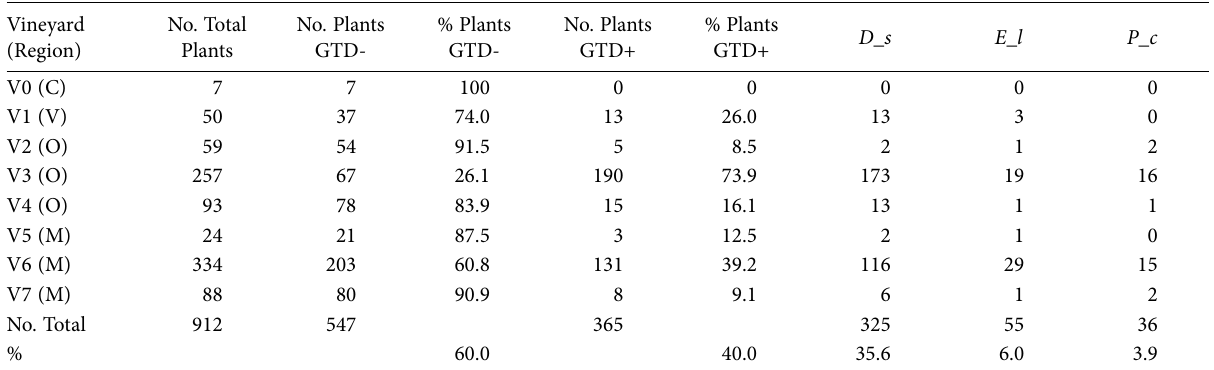
Table 3. Incidence of GTDs and GTD pathogens in seven Chilean vineyards. The vineyards are ordered from north to south of Chile. V = Vineyard, C = Coquimbo, V = Valparaíso, O = O´Higgins and M = Maule, n = number, GTD- = plants with no GTD fungi, GTD+ = plants with presence of GTD fungi. D_s = Diplodia seriata , E_l = Eutypa lata and P_c = Phaeomoniella chlamydospora . The numbers below each GTD fungus are the number of positive plants for that